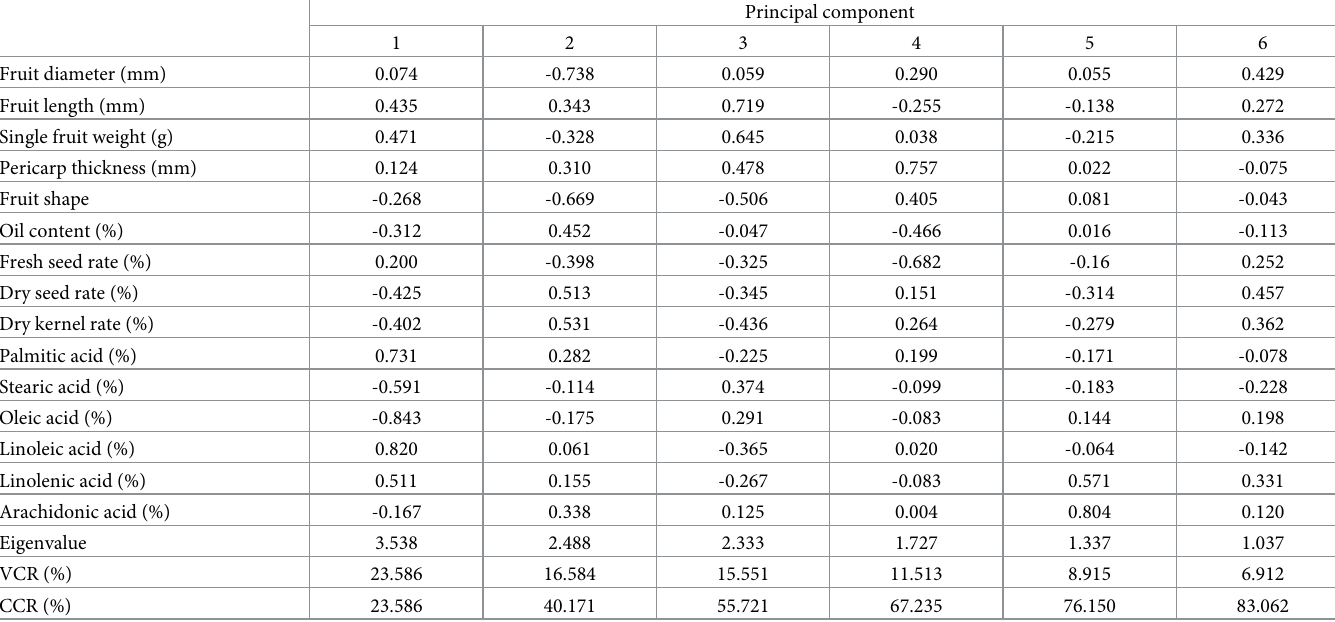
Table 2. Eigenvector, eigenvalues and variance contribution rates of the principal